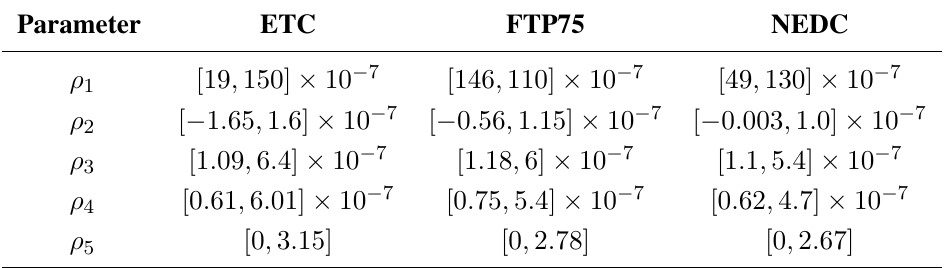
Table 1. Bounds on the parameter vector ρ under three conditions. ETC, European Transient Cycle; FTP75, Federal Test Procedure 75; NEDC, New European Drive